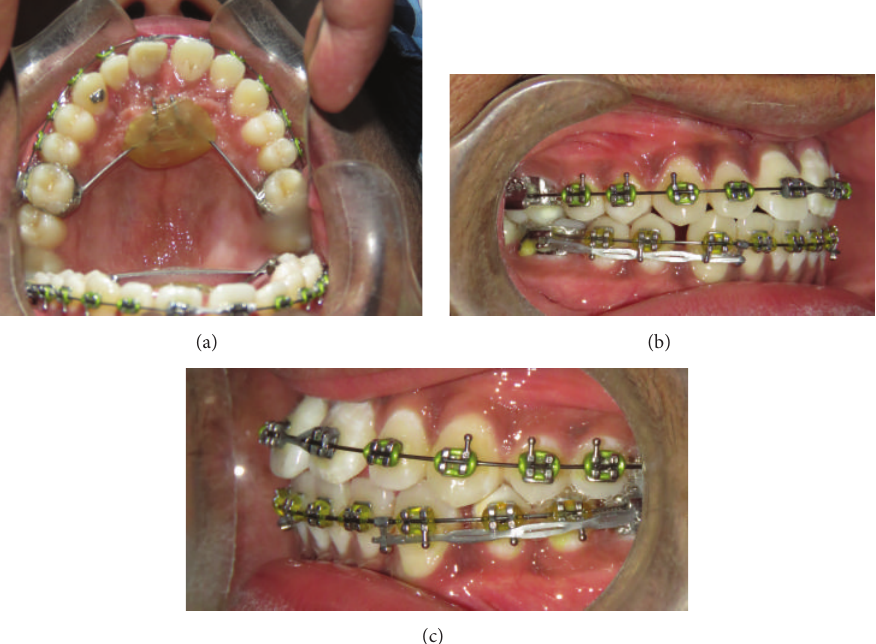
Figure 8: Clinical photographs of maxillary central incisor: (a) occlusal view, (b) right lateral view, and (c) left lateral view.